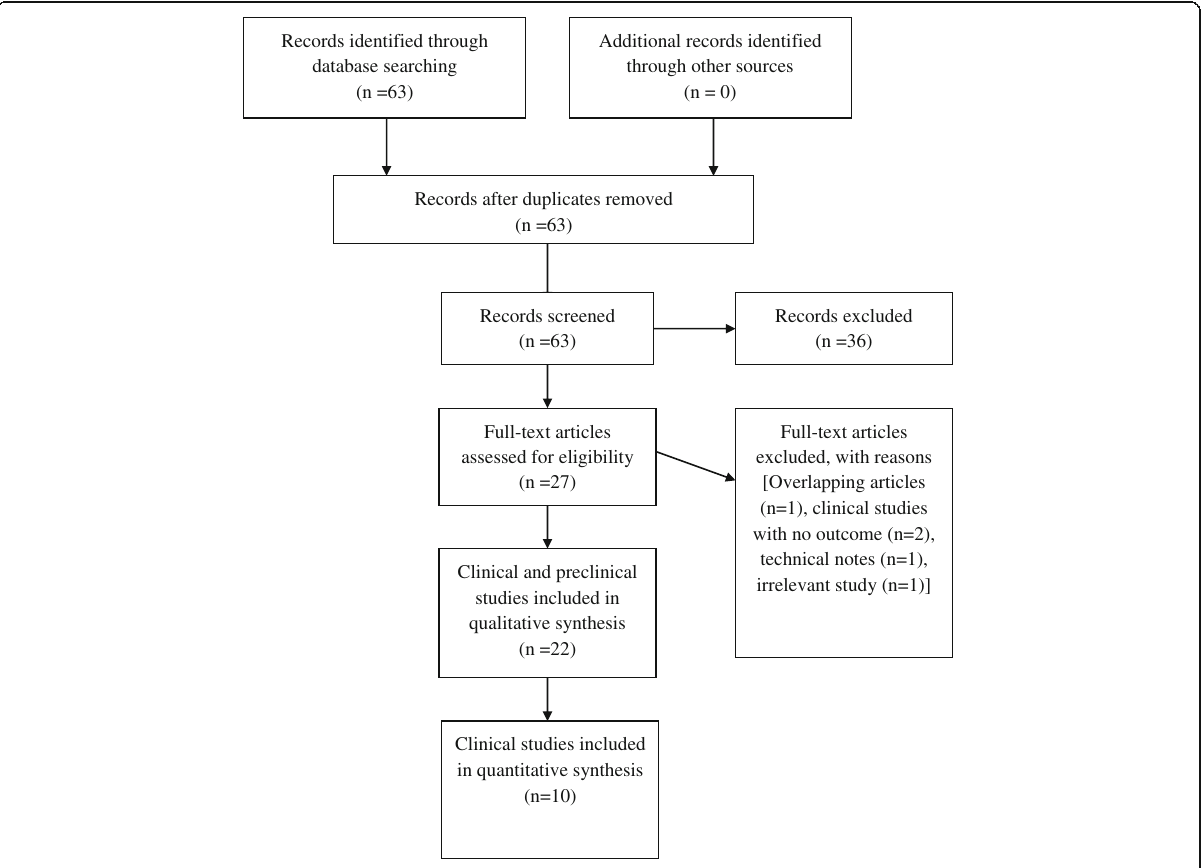
Fig. 1 Flow chart of study selection according to PRISMA guidelines for reporting systematic reviews and